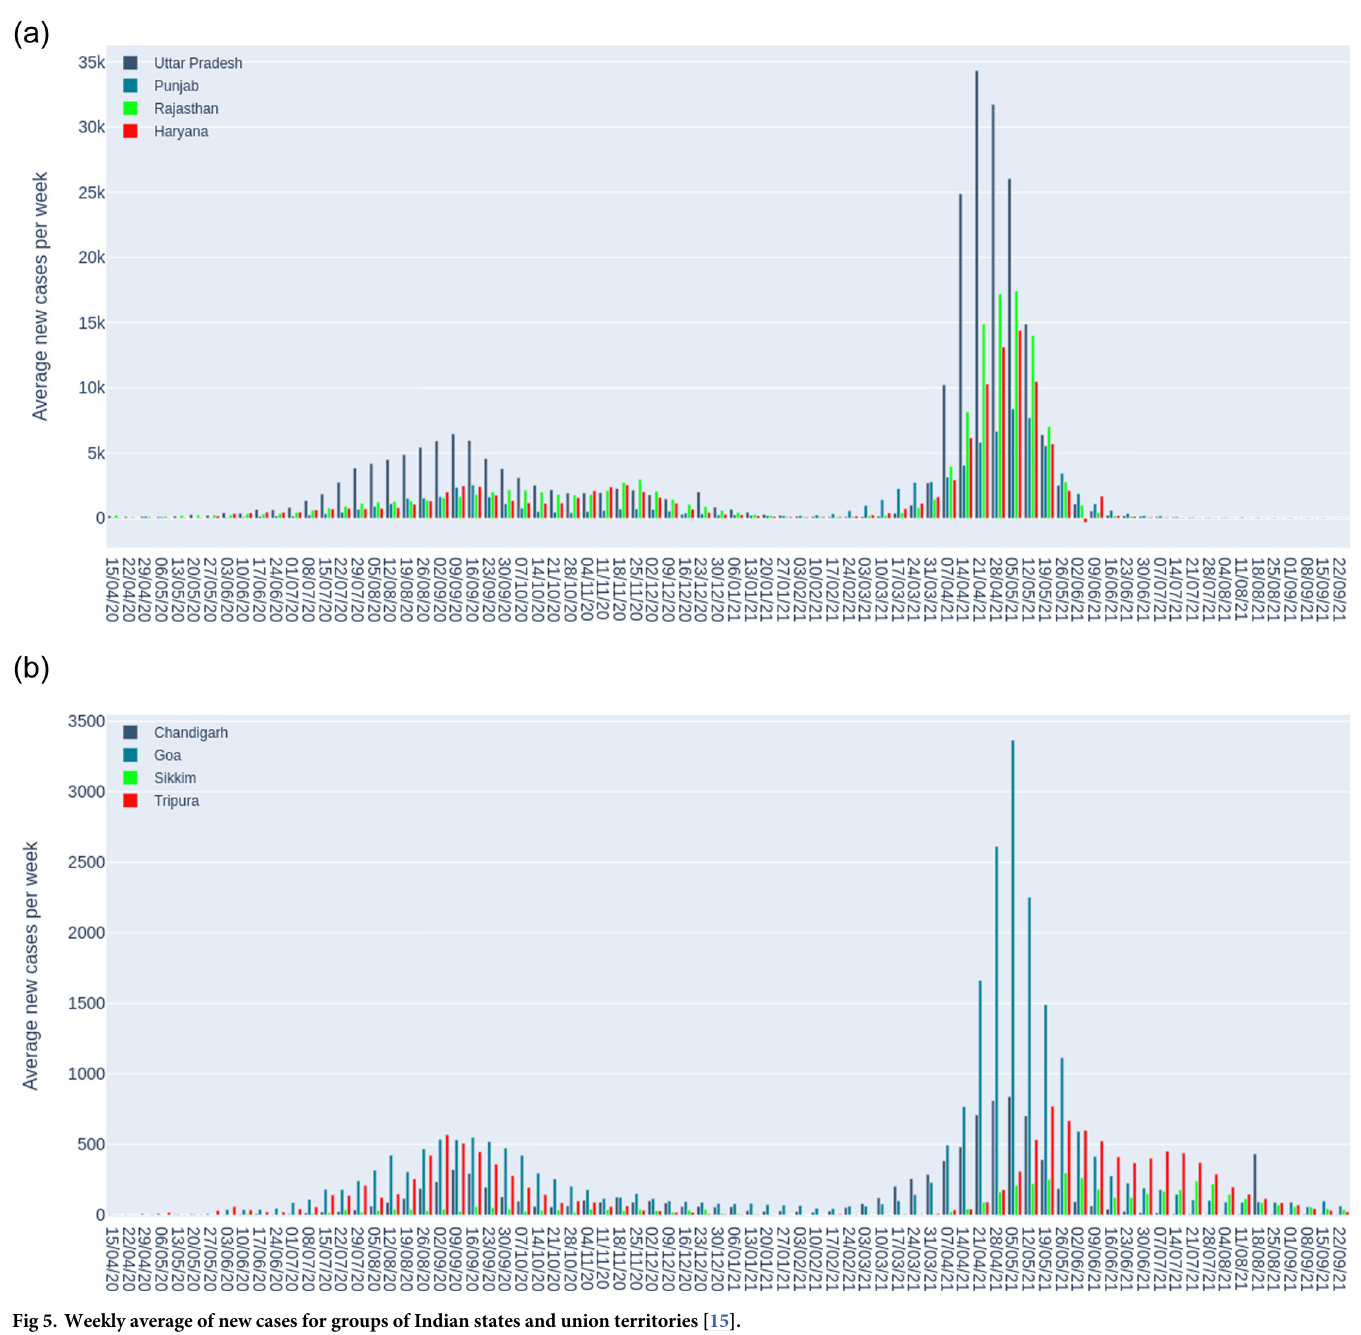
Fig 5. Weekly average of new cases for groups of Indian states and union territories